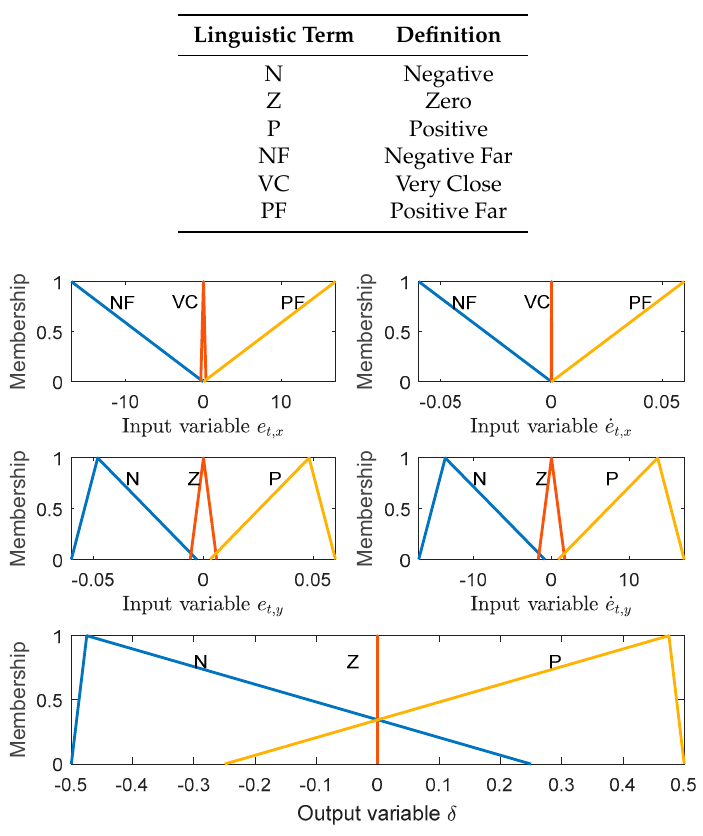
Table 2 . Linguistic terms definition. Table 2. Linguistic terms definition.